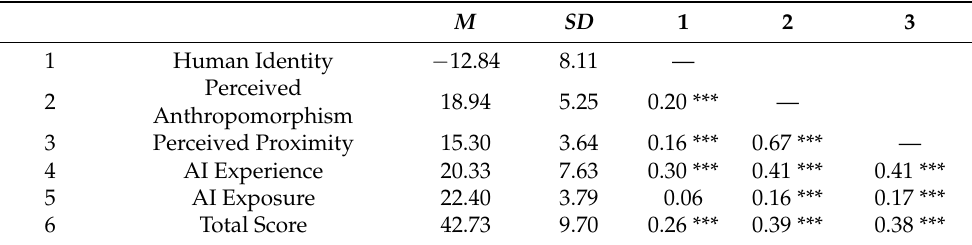
Table 3. Mean ( M ) and standard deviation ( SD ) of each variable and its Pearson correlation matrix, Study 1a.